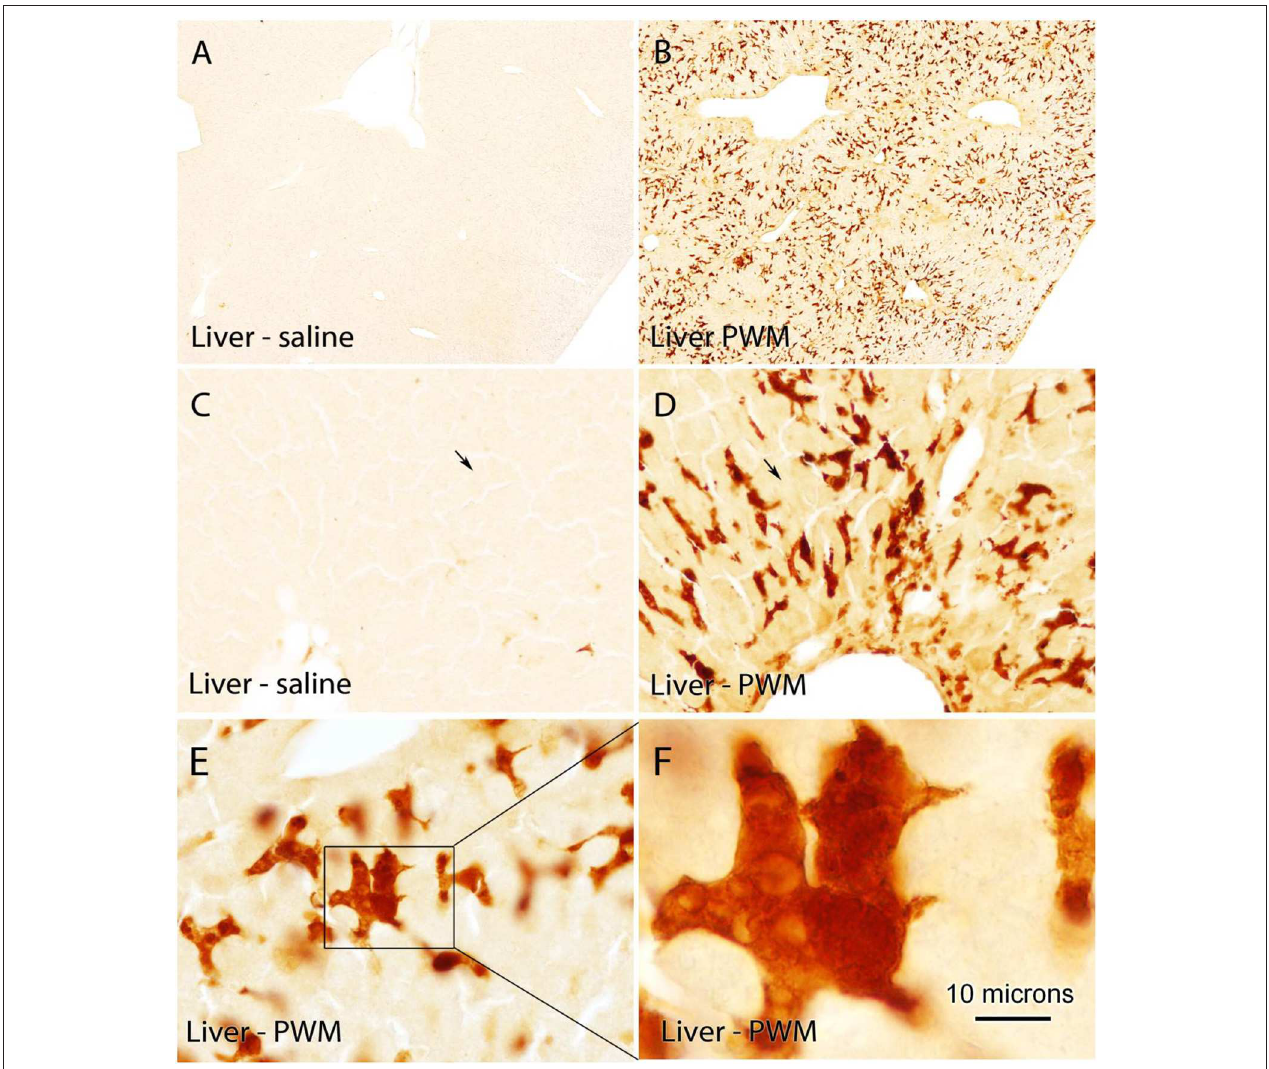
FIGURE 4 | Quin-IR in the gerbil liver 24h after IP PWM injection (500 µ g). Quin-IR was very low in the liver of saline-injected gerbils (A,C) . However, 24h after PWM injection, very strong Quin-IR was observed in cells throughout the liver (B) . Morphologically, the cells were identified as resident hepatic macrophages known as Kupffer cells (D,E,F) . Quin-IR increased slightly in hepatocytes in the PWM-stimulated liver (arrows in C,D ), but staining was substantially lower than in the presumptive Kupffer cells. Bar in (F) , 370 µ m in (A,B) , 74 µ m in (C,D) , 37 µ m in (E) , and 10 µ m in (F)